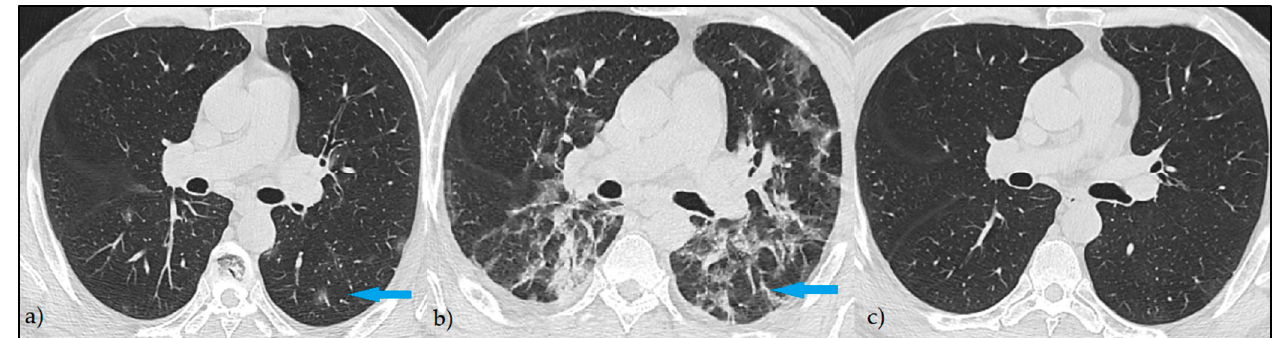
Figure 3. Persistent HRCT findings—Axial HRCT images: ( a ) extensive areas of GGO at the onset of the symptoms (blue arrow); ( b ) reticular pattern at 14 days from diagnostic (blue arrow); ( c ) per- sistent reticulation at 3 months with slightly decreased in attenuation (blue arrow). Figure 4. Persistent HRCT findings—Axial HRCT images: ( a ) extensive areas of GGO at the onset of the symptoms (blue arrow); ( b ) persistent areas of fine GGO with bronchiectasis, pleural traction, and pleural thickening at 3 months evaluation (blue arrow). 3.2. Time Intervals and Age Group Analysis The time interval analysis presented in Table 2 identified a majority of 46.02% of pa- tients enrolled in the current study being evaluated between 30 and 60 days with HRCT after the first positive COVID-19 test and hospital admission. A total of 21.78% of the pa- tients were evaluated between 60 and 90 days, while only 5.68% benefited from HRCT at a period shorter than 30 days from the positive PCR test.